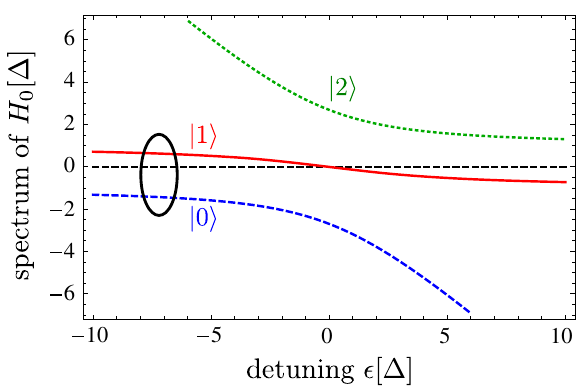
5 Δ . The three eigenstates j l i c ¼ i are assumed (cid:4) , the hybridized levels fj 0 i ; j 1 ig c